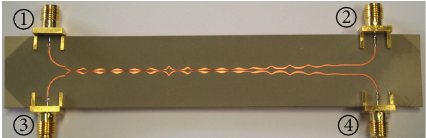
Figure 3: Photograph of the fabricated EBG microstrip directional coupler with high directivity and coupling. The ground plane is